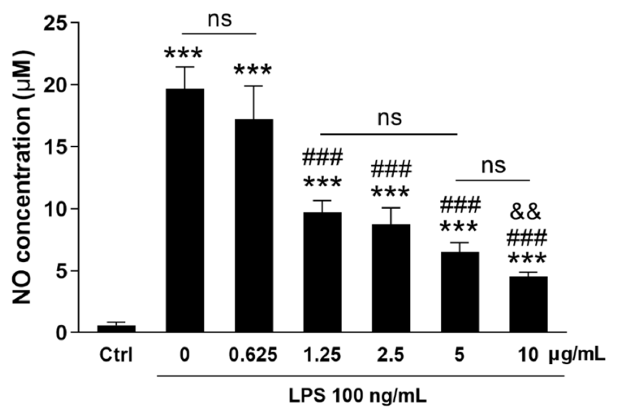
Figure 8. AKR1C15 reduced LPS-induced NO release in microglial cultures. Primary rat microglial cultures were treated with 100 ng/mL LPS in the presence of TAT-AKR1C15 at indicated doses for 24 h, and NO concentration in the culture media was measured. Data are mean ± SD. n = 4–6 independent experiments. One-way ANOVA followed by Tukey’s multiple comparison. *** p < 0001 vs. Ctrl. ### p < 0.001 vs. 0 and 0.625 µg/mL groups. && p < 0.01 vs. 1.25 and 2.5 µg/mL groups. ns: not significant. LPS: lipopolysaccharides. NO: nitric oxide.